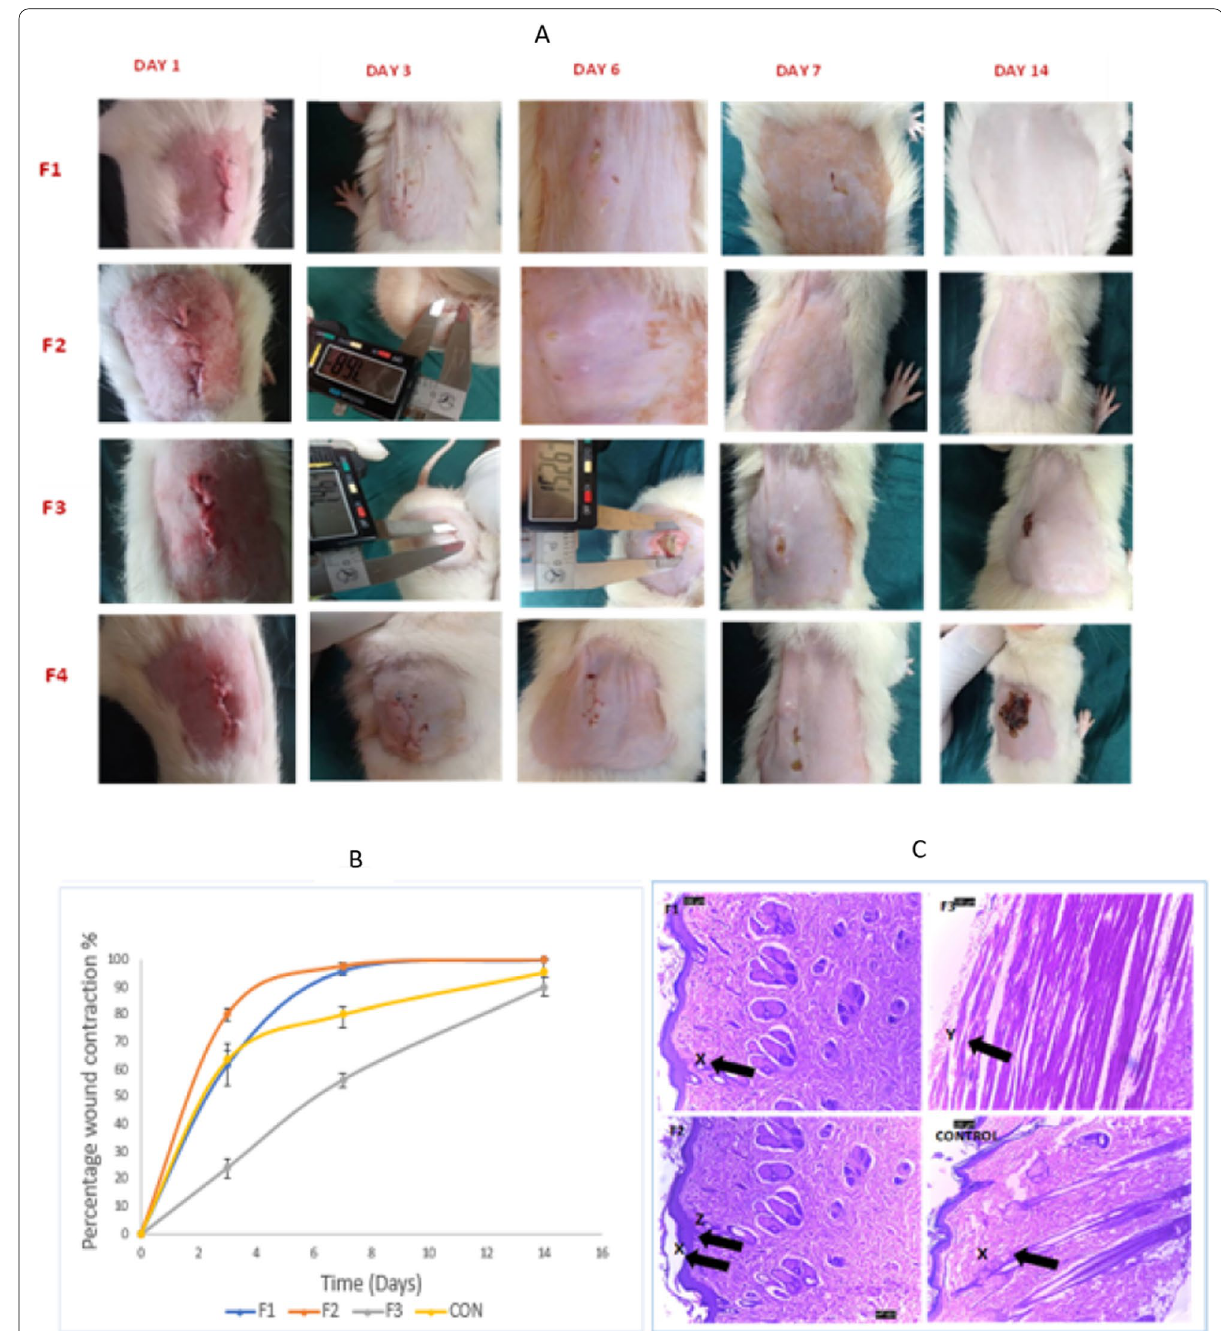
Fig. 5 The effect of formulations F1–F3 on the rate of wound healing in the surgical wound model ( A ). Percentage relative wound size reduction from days 1 to day 14 (post‑surgery) for surgical wounds ( B ). Skin tissue section of wound area from a representative rat in (F1–F3, and control) stained with haematoxylin and eosin 14 days post wound incision ( C